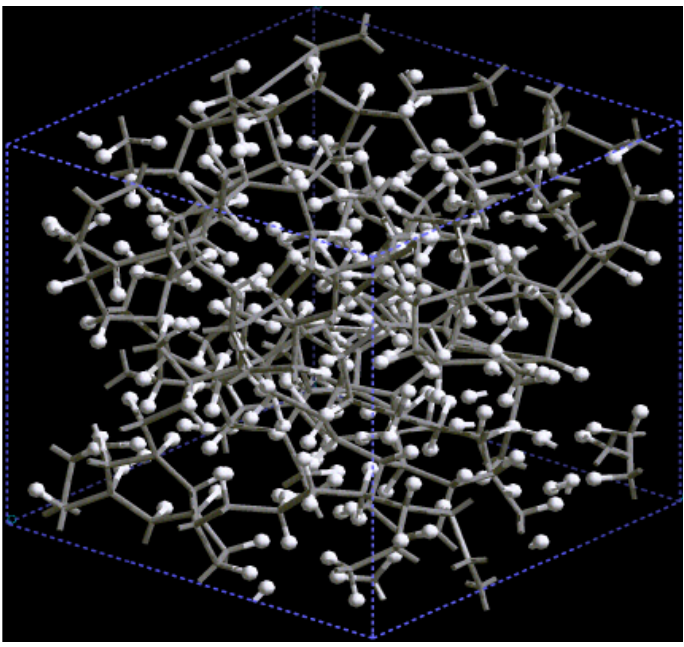
Figure 17. Starting with the relaxed amorphous porous carbon structure, the dangling bonds were saturated with 260 hydrogens and the supercell was geometry